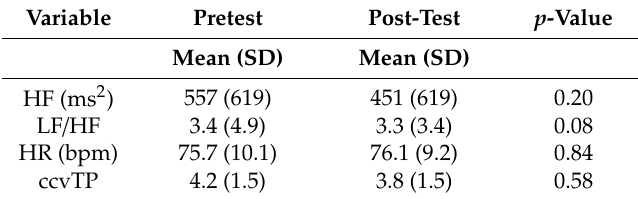
Table 3. Mean heart rate variability values pretest and post-test ( n = 38).